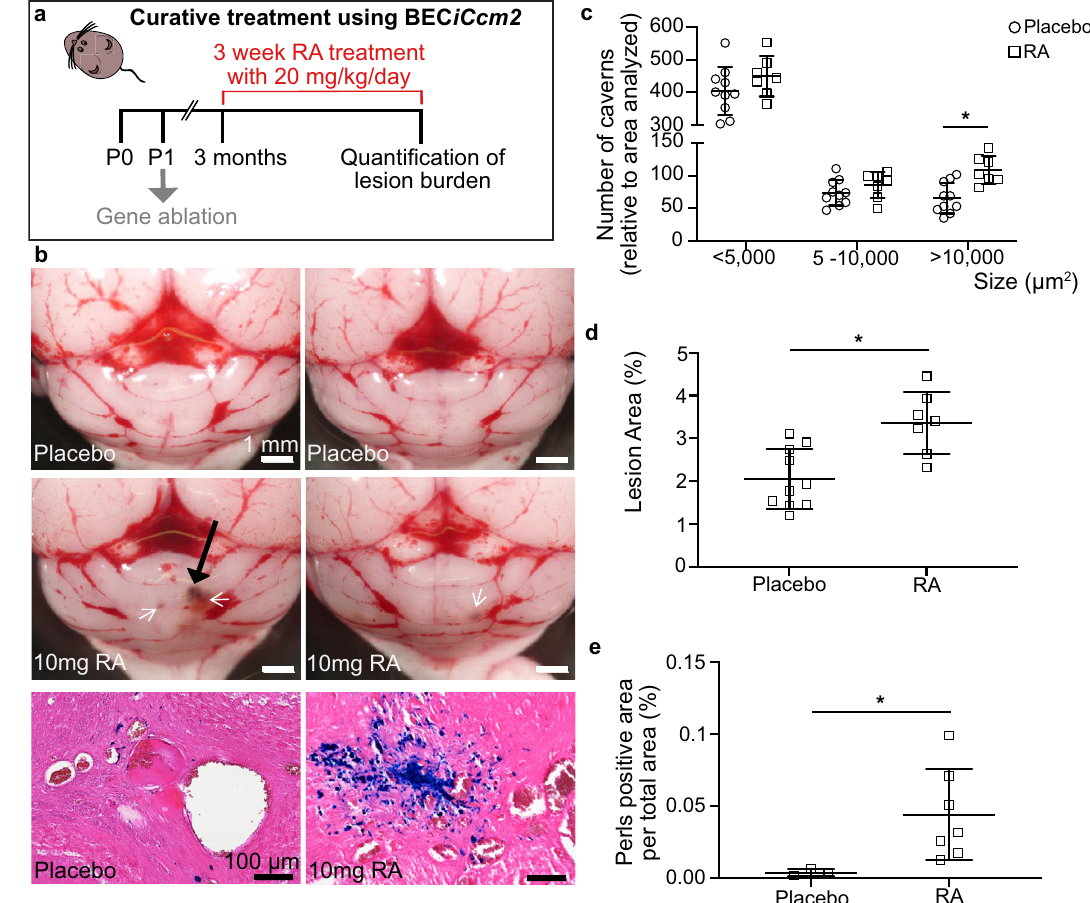
Figure 3. Curative RA trial in BEC iCcm2 mice. (a) Treatment regimen with brain-endothelial-cell-specific gene ablation at P1 followed by RA treatment at three months of age for a period of 3 weeks (10 mg containing pellets with a release of ~ 20 mg/kg/day for 21 days). ( b) Extracted BEC iCcm2 mouse brains after treatment. Upper: placebo treated controls. Middle: brains after 10 mg of RA treatment. Black arrows indicating hemorrhage, white arrows pointing at visible lesions. Lower: histological sections of cerebral cavernous malformation (CCM) lesions after treatment. Perls blue stain reveals non-heme iron deposition. Scale bars: 1 mm (upper and middle); 100 µm (lower). ( c) Quantification of lesion burden in cerebella of placebo versus 10 mg RA treated mice. Lesions are quantified in three groups according to their size. Each datapoint represents one animal. Error bars represent mean with SD. ( d ) Quantification of lesion area as percentage of total area analyzed (*P < 0.05). ( e ) Quantification of Perls blue staining positive area per total area analyzed (*P < 0.05; **P < 0.01). Error bars represent mean with